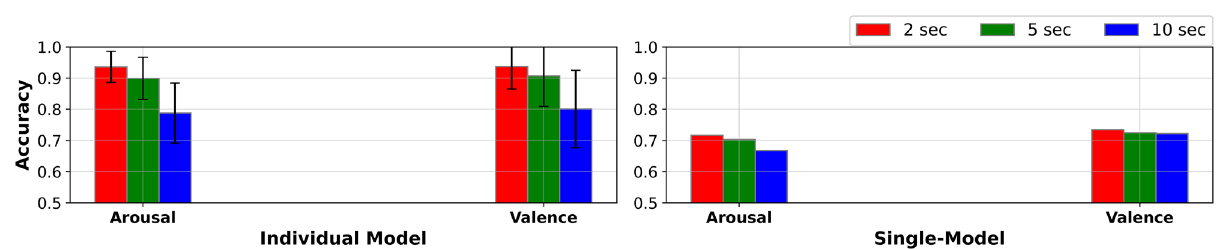
Figure 3. Left: Average accuracies and standard deviation obtained with EEGNet per each subject for low vs high arousal/valence classification using all the EEG channels from 2, 5 and 10-s signal segments. Right: Accuracies obtained with a single EEGNet model with data from all the subject for low vs high arousal/valence classification using all the EEG channels from 2, 5 and 10-s signal